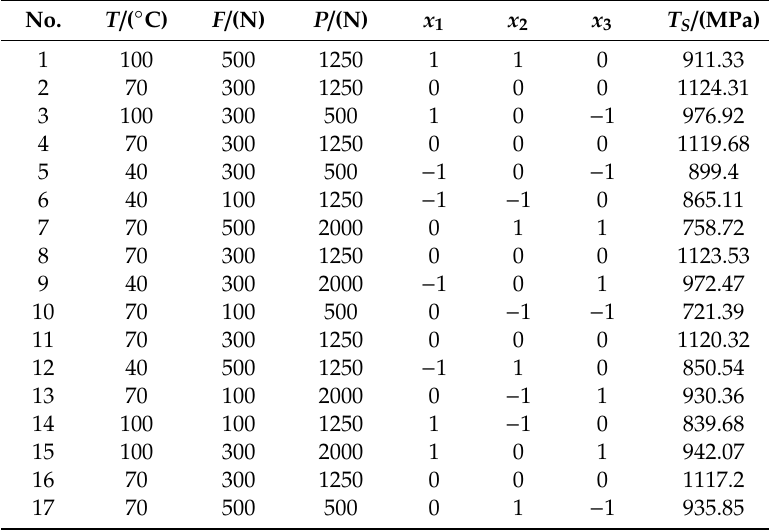
Table 2. The experiment results.